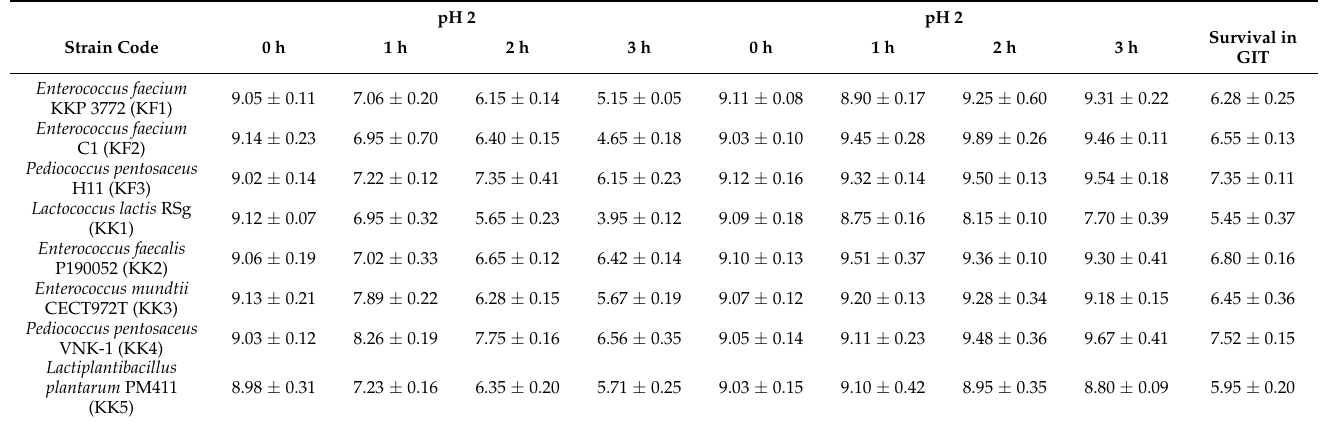
Table 3. The survival of LAB isolates of Abadeh (Fars) and Kalat (Razavi Khorasan) kashk samples in pH 2 and 3, as well as simulated conditions of the gastrointestinal tract (GIT) (Log CFU/mL). pH 2 pH 2